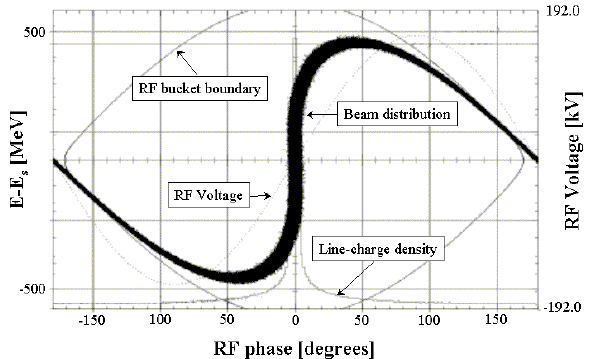
FIG. 2. (Color) The figure shows the beam properties after nonlinear compression. Plotted are the s -shaped phase space area, the rf bucket area (solid line), the harmonic rf voltage (dotted line), and the particle distribution in the longitudinal